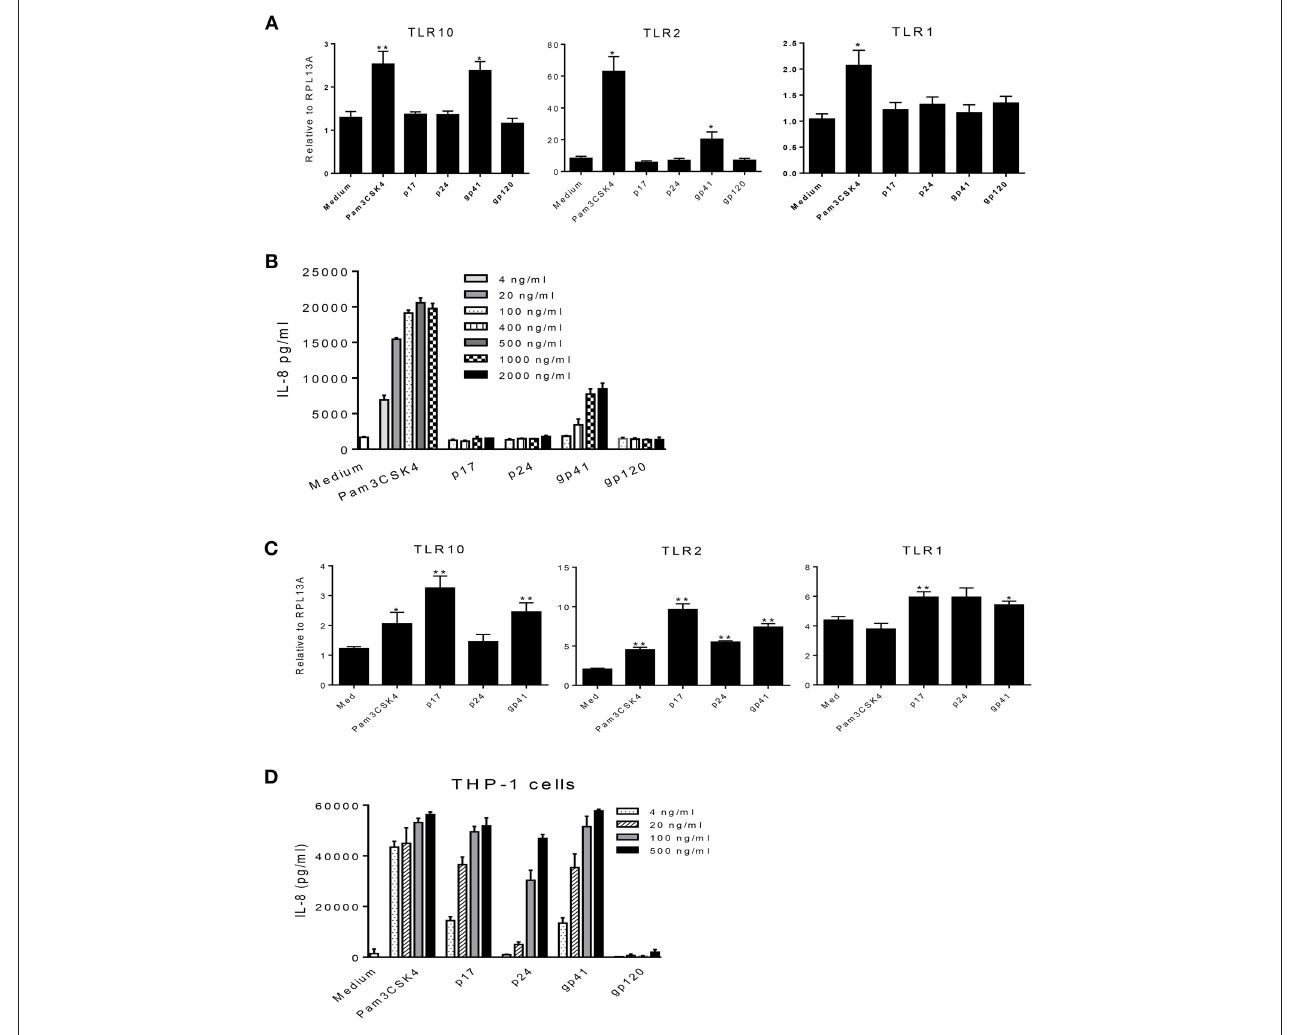
FIGURE 5 | Effects of HIV-1 proteins on TLR expression and cellular responses. (A) MCF-10A cells were treated with Pam3CSK4 and the HIV-1 structural proteins: p17, p24, gp41, and gp120. Cellular TLR10, TLR2, and TLR1 mRNAs were analyzed by qRT-PCR. (B) IL-8 production in cell culture supernatants in the presence of different concentrations of Pam3CSK4 and HIV-1 proteins were analyzed by ELISA. (C) The expression of TLR mRNAs analyzed by qRT-PCR in THP-1 cells treated with Pam3CSK4 and the HIV-1 structural proteins: p17, p24, and gp41. (D) IL-8 production in THP-1 cell culture supernatants in the presence of different concentrations of Pam3CSK4 and HIV-1 proteins was analyzed by ELISA. Data set is representative of three different experiments completed in triplicate. Statistic marks: * p < 0.05 , ** p < 0.01 for the Mann-Whitney t -tests, each group was compared to the medium-treated group